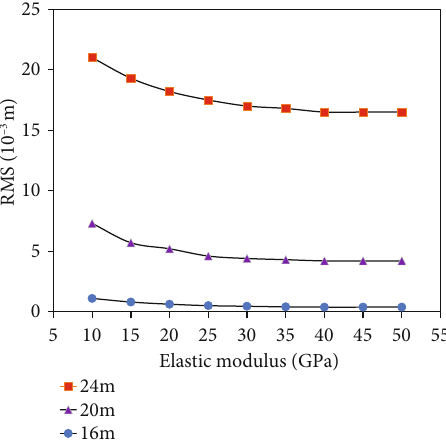
Figure 14: E ff ect of the elastic